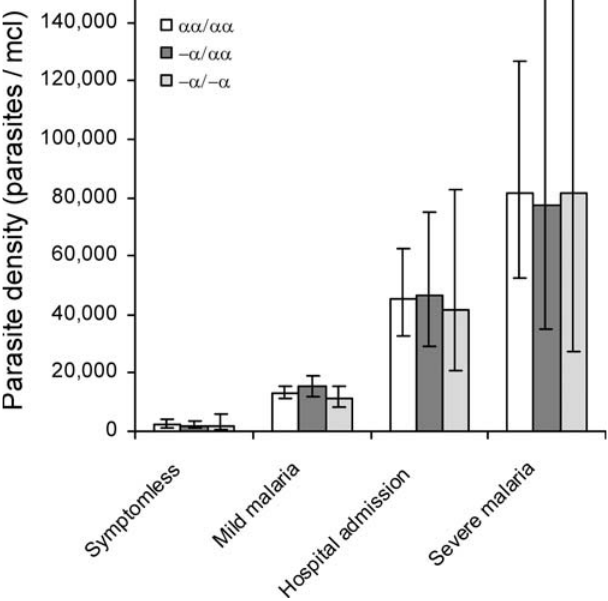
Figure 1. Parasite Densities by Clinical Status and a þ -Thalassaemia Genotype Geometric mean parasite densities are shown with 95% CIs. Data on symptomless parasitaemia reflect 59 measurements on normal ( aa / aa ) children, 100 on heterozygotes ( (cid:1) a / aa ), and 23 on homozygotes ( (cid:1) a / (cid:1) a ) for a þ -thalassaemia. The equivalent figures for mild, hospital, and severe malaria are described in Tables 1 and 2. Between-genotype differences were tested using linear regression both with and without adjustments for age, season, and within-patient clustering. No significant differences were